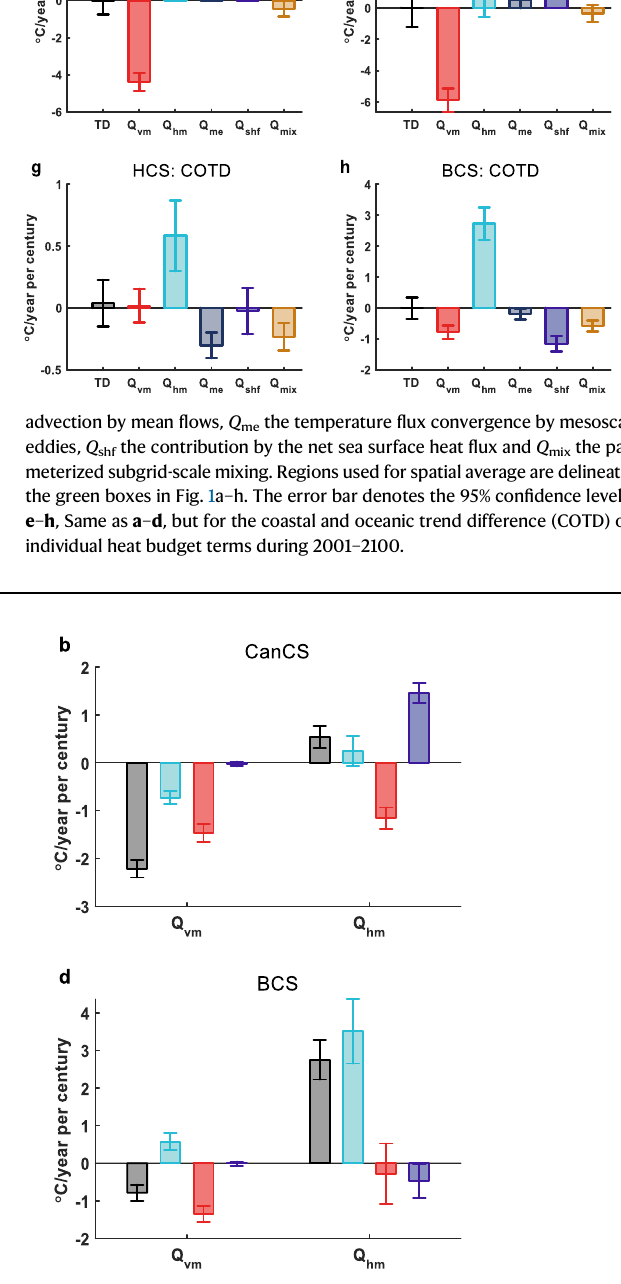
bars denote the coastal and oceanic trend difference (COTD) of mean- fl ow advectionduring2001 – 2100(thesameastheircounterpartsinFig.3e – h).Theblue and red bars denote the contribution by the mean fl ow change and mean-state temperature change, respectively; the purple bar (the residue term) denotes their interaction effects. The errorbar is the 95% con fi dence level. See “ Heat budget analysis ” in “ Methods ” for more computational